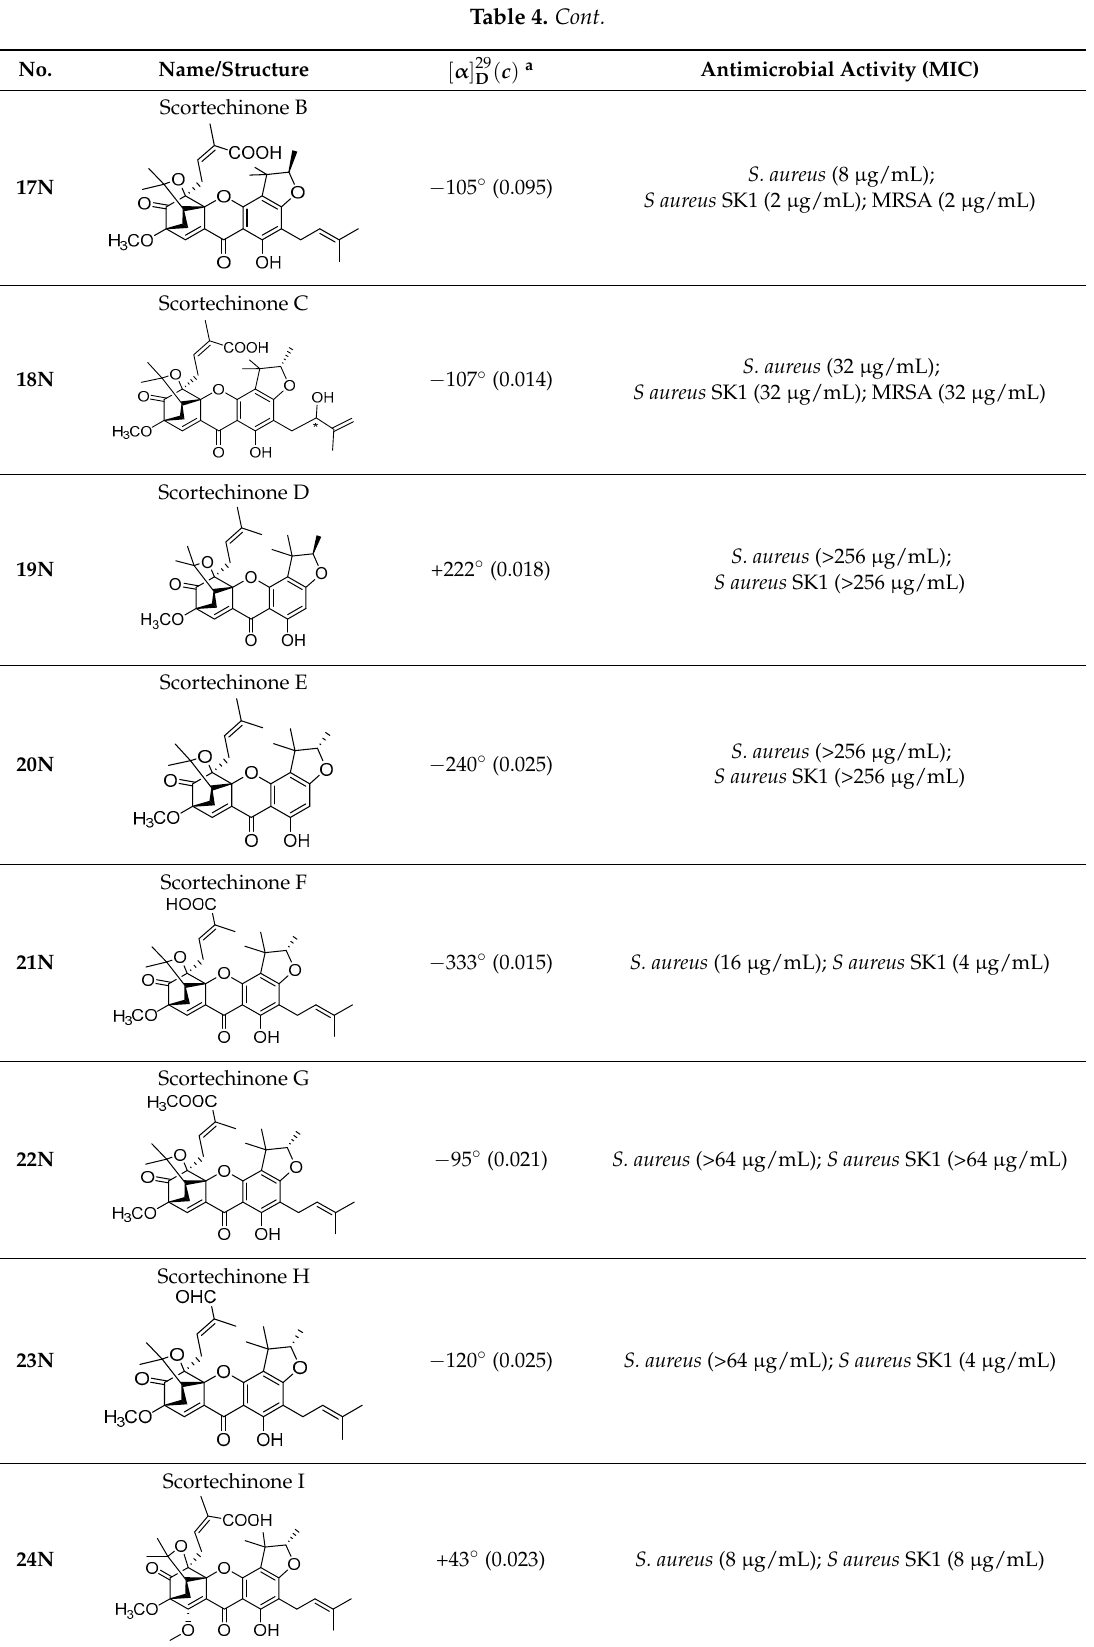
Table 4. Antimicrobial activity of natural caged xanthones: scortechinones and prenylated.